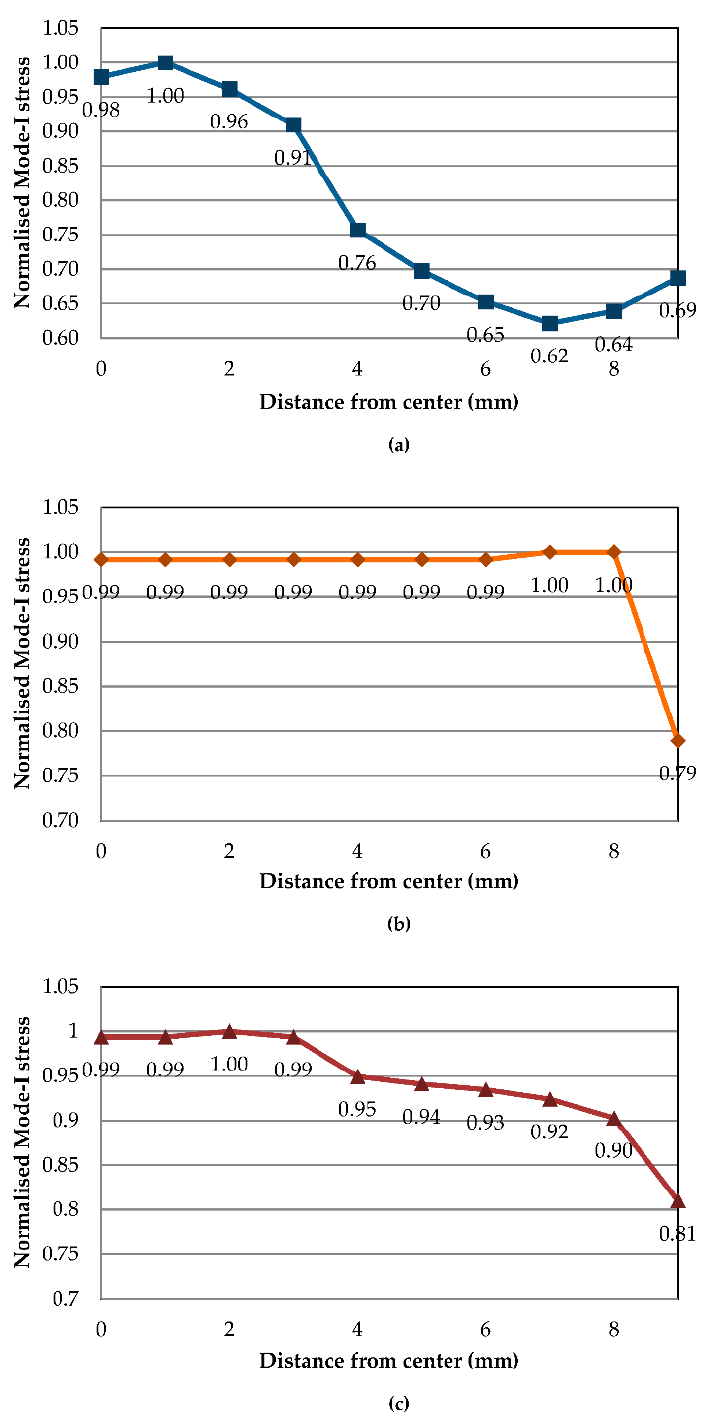
Figure 8. Normalised Mode-I stress distribution along the crack front at ( a ) 30, ( b ) 70 and ( c ) 110 °C.